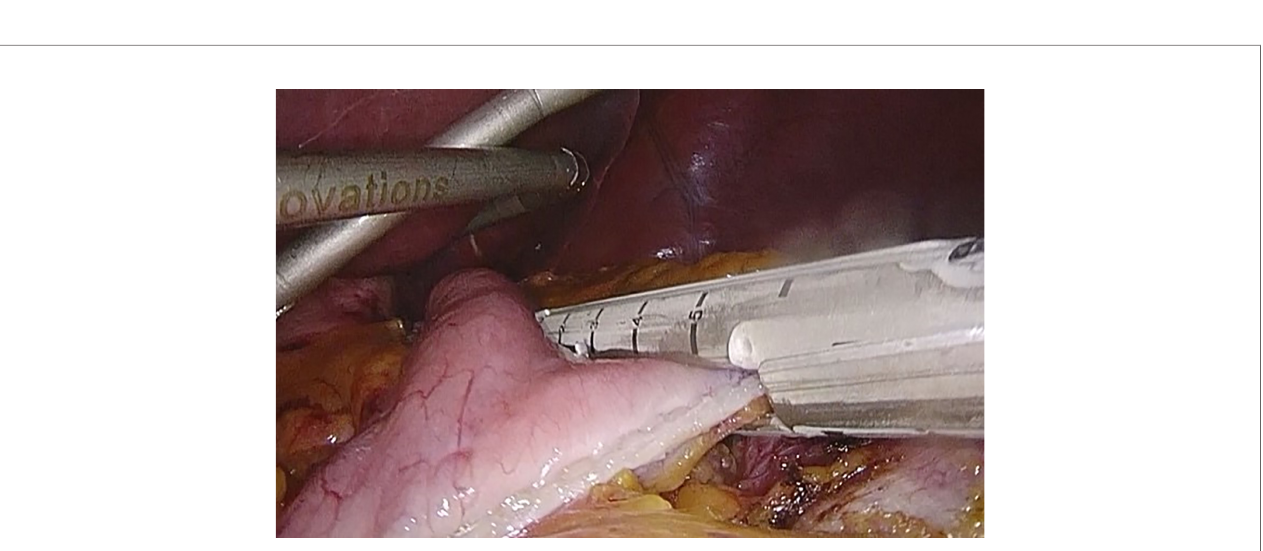
FIGURE 2 | Linear mechanical stapling of the stomach, to make the gastric reservoir. Taken from the General Surgery and Digestive System Service, Hospital Royo